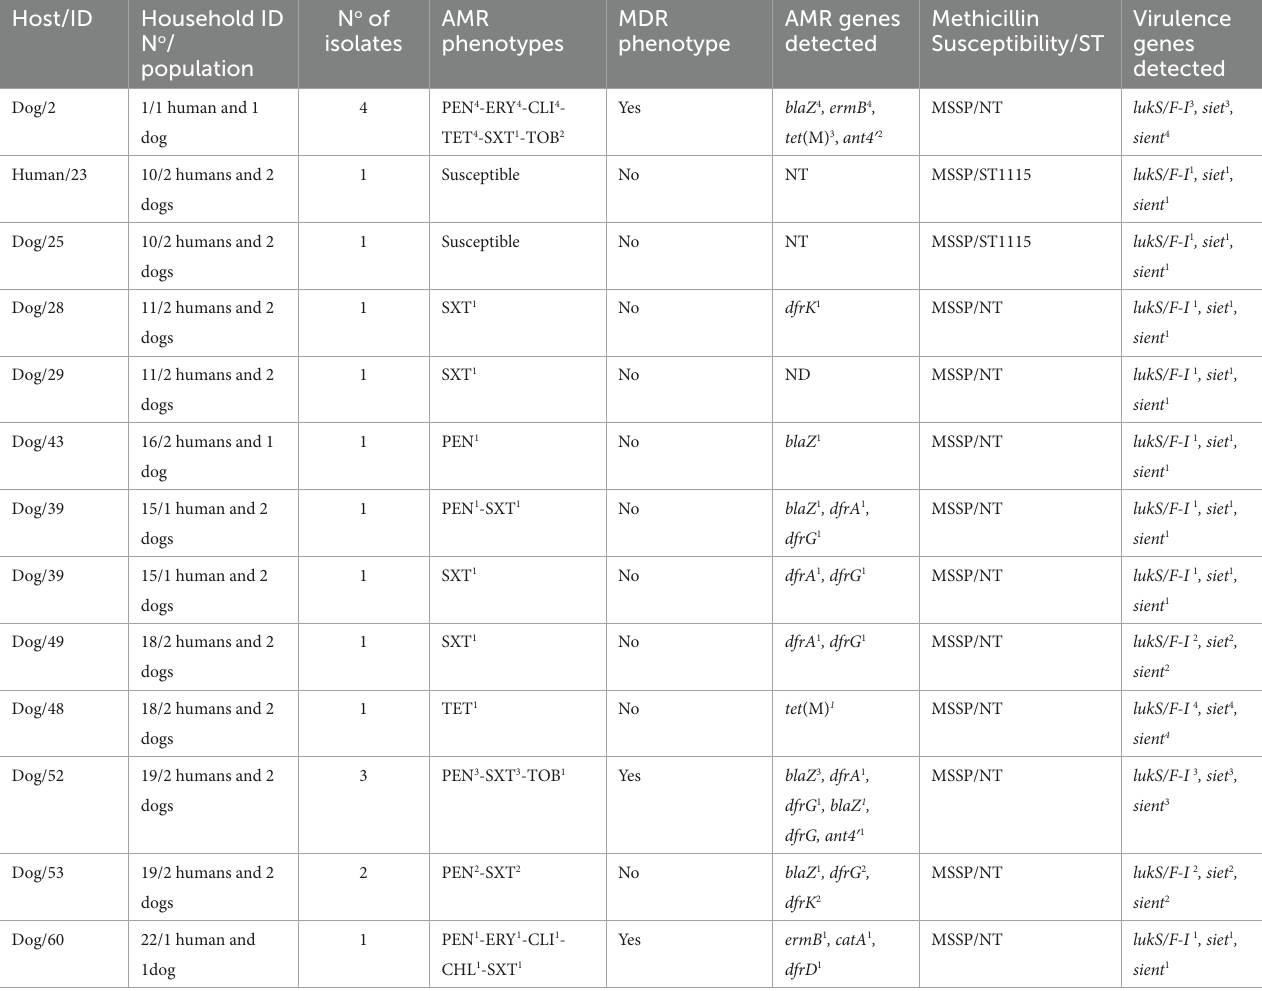
TABLE 3 Intra-host variation of AMR determinant and virulence factors of S. pseudintermedius